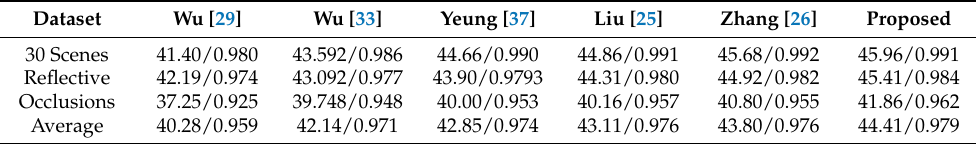
Table 1. Numerical comparison (PSNR/SSIM) of the proposed model with the state-of-the-art models to reconstruct 7 × 7 views out of 3 × 3 views on datasets 30 Scenes, Reflective, and Occlusions.